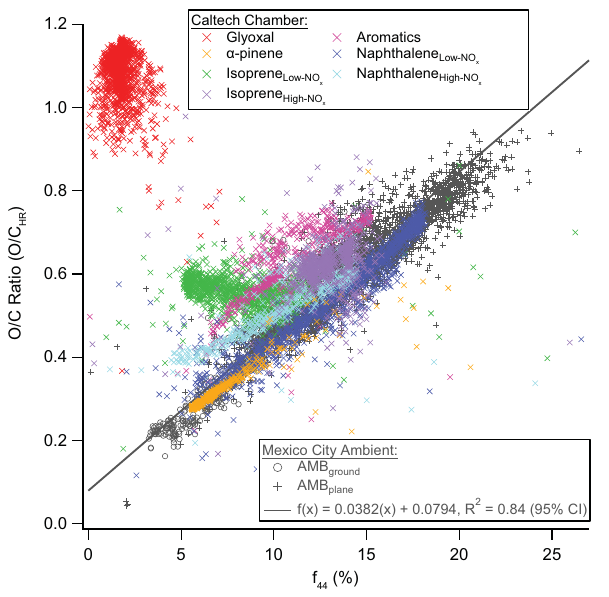
Fig. 15. O / C HR vs. f 44 for ambient Mexico City OA (Aiken et al., 2008, Fig. 4) and chamber OA. The solid line represents the corre- lation derived from ambient data. Experiments 19, 22, and 26 are not shown for simplicity.